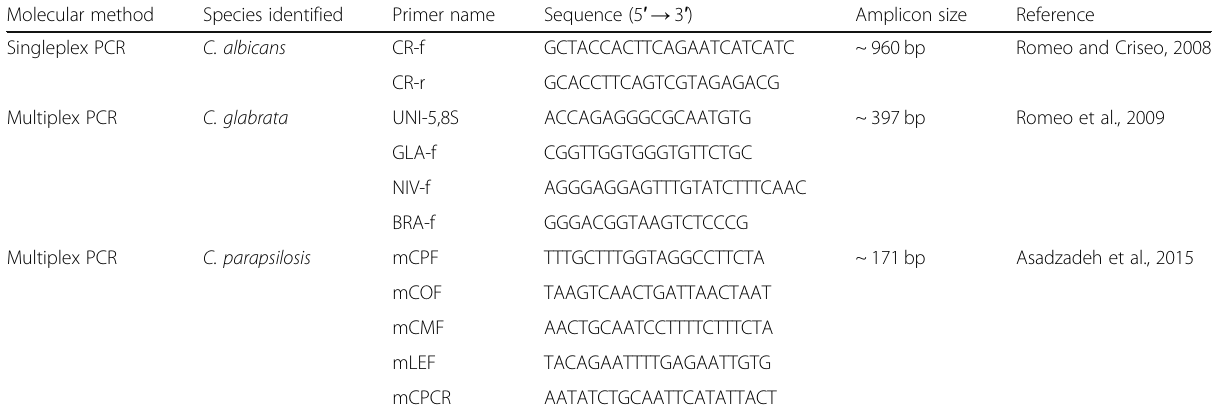
Table 1 PCR primers used for molecular identification of Candida species tested in this study